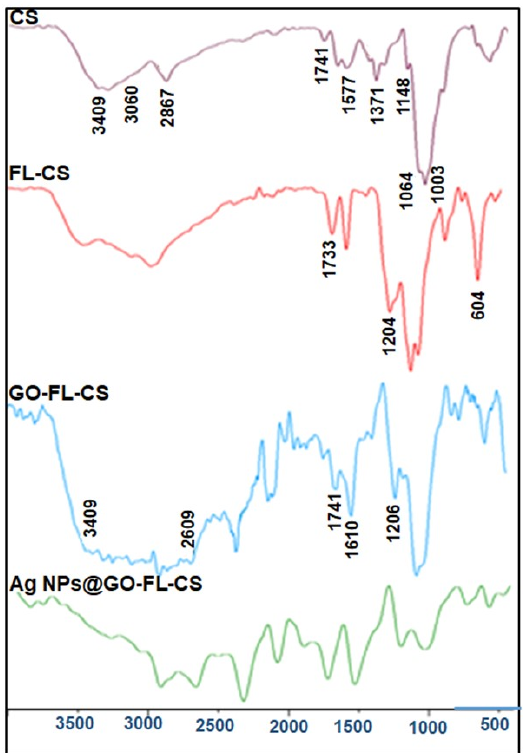
Figure 1. FTIR spectra of CS, FL-CS, GO-FL-CS, and Ag NPs@GO-FL-CS.